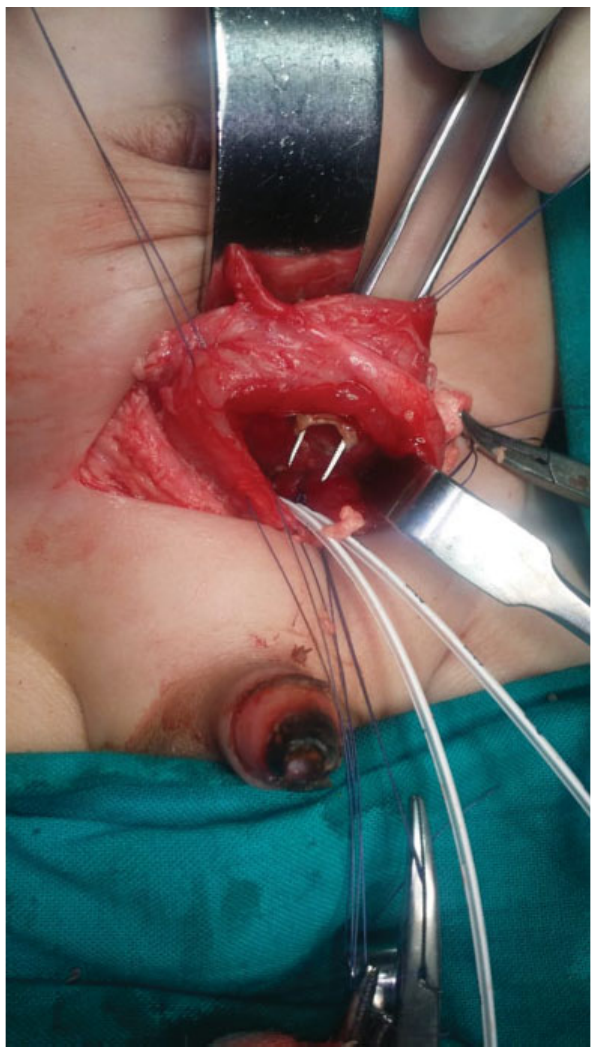
Fig. 3 Intraoperative view. The bladder is bivalved (opened), the ureters are cannulated and the perforation is